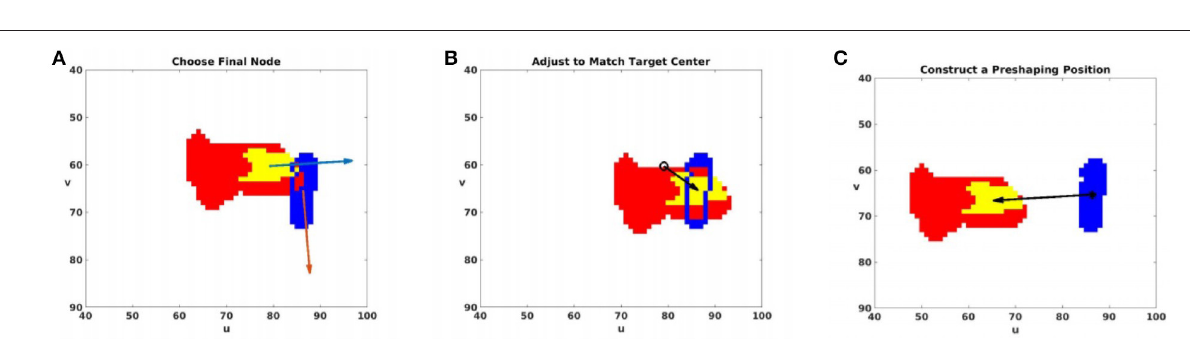
FIGURE 10 | The agent plans modifications to the end of the trajectory, and defines a preshaping configuration q ∗ p . Human intuition and the agent’s learning recognize that all vectors describing gripper direction and the direction of motion should be near parallel, with all of these vectors near perpendicular to the target’s major axis. The agent plans a final motion with these features in three steps: (A) The agent chooses n f from the candidate final nodes (Equation 11) to minimize C ( E g f , E o ). This image displays the palm mask (yellow) and hand mask (red) for the chosen n f , along with the target mask (blue). A blue outline is used to show the boundary of the intersection between the hand and target. E g f and E o are displayed in light blue and orange, respectively. (B) The agent uses ˆ J + ( n f ) to estimate the change in joint angles necessary to cause the image-space translation shown here. This translation improves the approach accuracy by aligning c p f with c t by moving to q ∗ f . (C) The agent constructs q ∗ p by Equation (15), which is predicted to have masks translated as shown from those for q ∗ f . A final motion from q ∗ p to q ∗ f has aligned gripper and motion